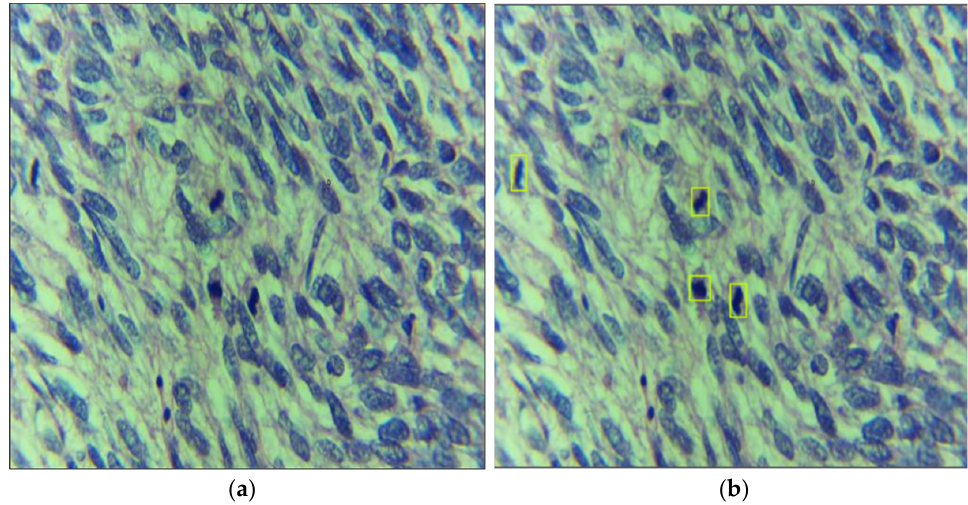
Figure 3. Data annotation process: leiomyosarcoma (LMS) datasets with ( a ) sample image and ( b ) annotated image with mitosis region being highlighted.